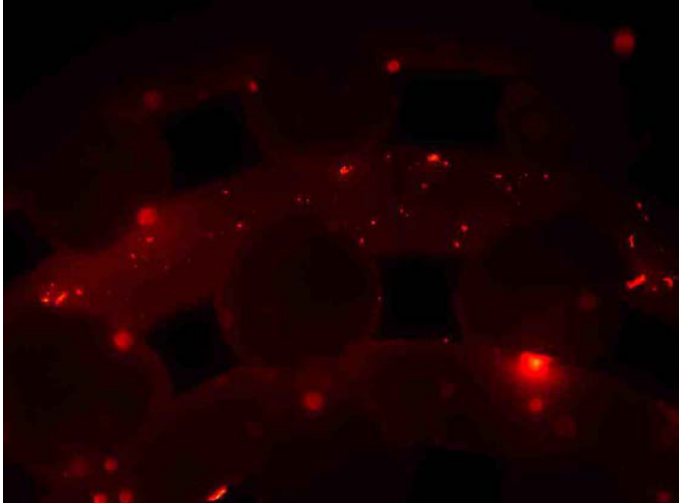
Figure 7. Fluorescent microscopy picture showing the attachment of the cells to the surface of the material.